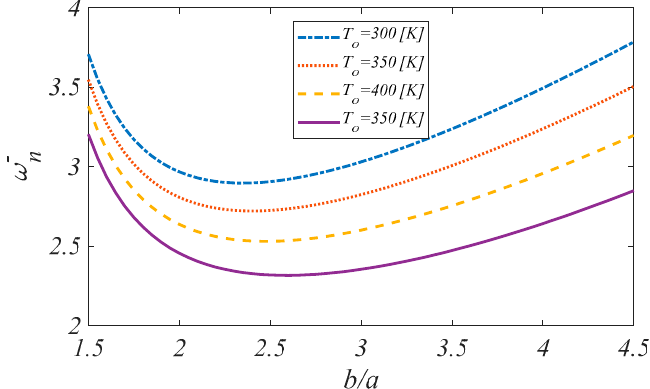
Figure 8. The e ff ect of applied temperature of the top surface on the nondimensional natural frequency Figure 8. The effect of applied temperature of the top surface on the nondimensional natural of MHCAP with clamp-clamp boundary conditions for di ff erent outer radius ratios of inner radius frequency of MHCAP with clamp-clamp boundary conditions for different outer radius ratios of inner and h / b = 0.1, T i = 273 [K], UTR, θ = π / 4, W CNT = 0.02, V F = 0.2, FG-A, β = 1, K p = 10 [MN / m], radius and h/b = 0.1, T i = 273 [K], UTR, θ = π /4, W CNT = 0.02, V F = 0.2, FG-A, β = 1, K p = 10 [MN/m], and and K w = 100 [MN / m 3 K w = 100 [MN/m 3 ].